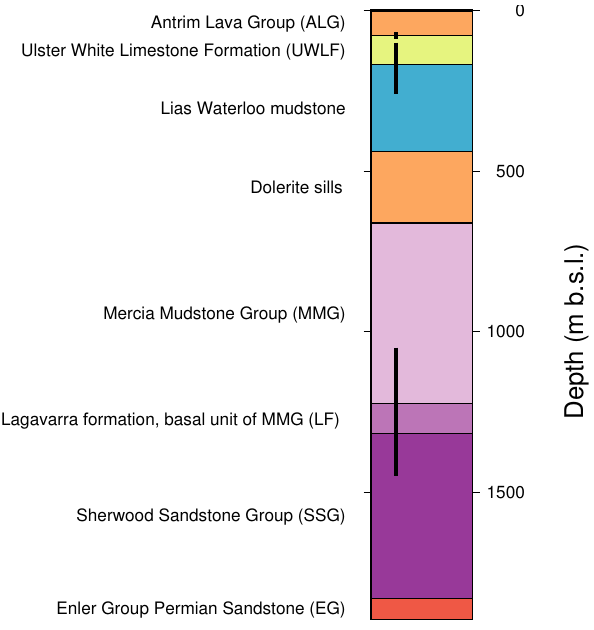
Figure 2. Stratigraphy encountered in the Port More 1 borehole (left), and measured normal resistivity data (right). Stratigraphy encountered includes Paleogene Antrim Lava Group of basalts and tuffs, Cretaceous Ulster White Limestone Formation, Juras- sic Lower Lias sandstones, Late-to-Mid-Triassic Mercia Mud- stone Group, Early-Triassic Sherwood Sandstone Group, and late- Permian Enler Group sandstones. Due to technical difficulties the resistivity data were acquired in three sections.